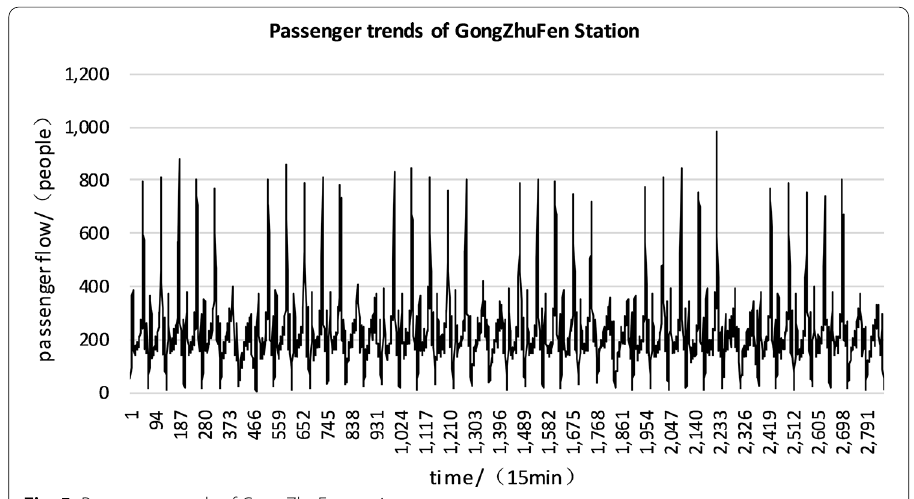
Fig. 5 Passenger trends of GongZhuFen